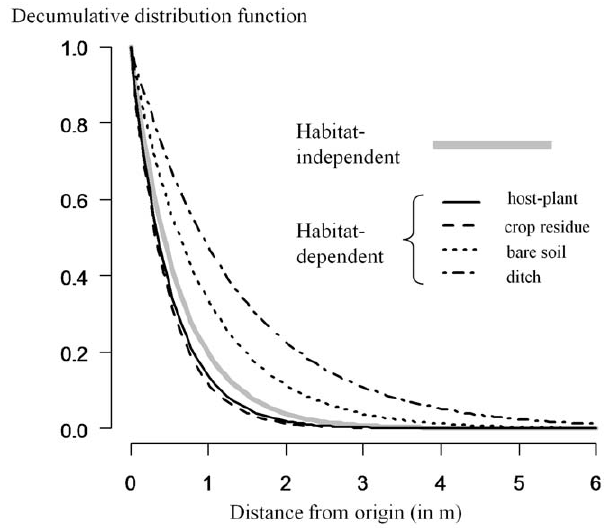
Figure 1. The ‘‘de´cumulative’’ distribution function as a function of length of animal displacement (d), i.e., f(d)=exp( 2 b .d) . Maximum likelihood estimates of exponential kernels are drawn for the habitat-independent (grey line) and the habitat-dependent (black lines) models. The slopes of the black curves depend on the estimated value of parameter b h for the habitat type h of the individual’s location before movement.